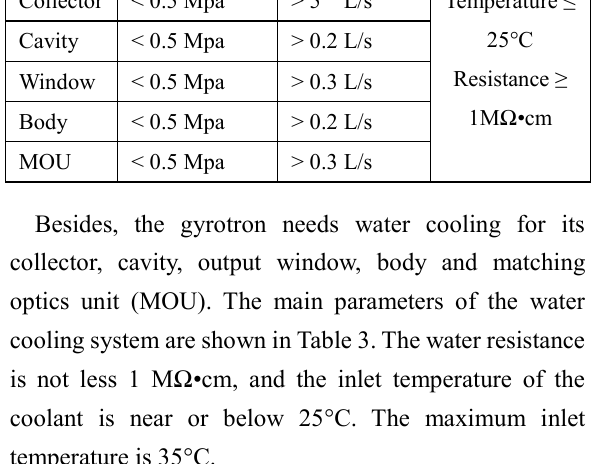
Table 1. Parameters of gyrotron.